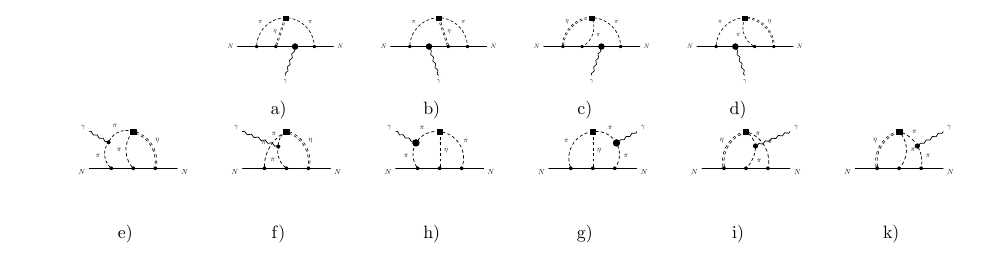
Figure 1. Diagrams contributing to the nEDM which are induced by the minimal electromagnetic couplings of proton and charged pions. The solid square denotes the CP-violating ηπ + π − vertex.